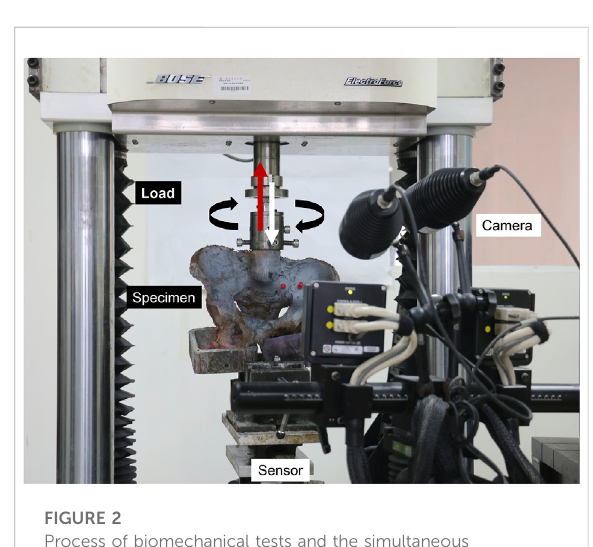
FIGURE 2 Process of biomechanical tests and the simultaneous noncontact optical 3D strain